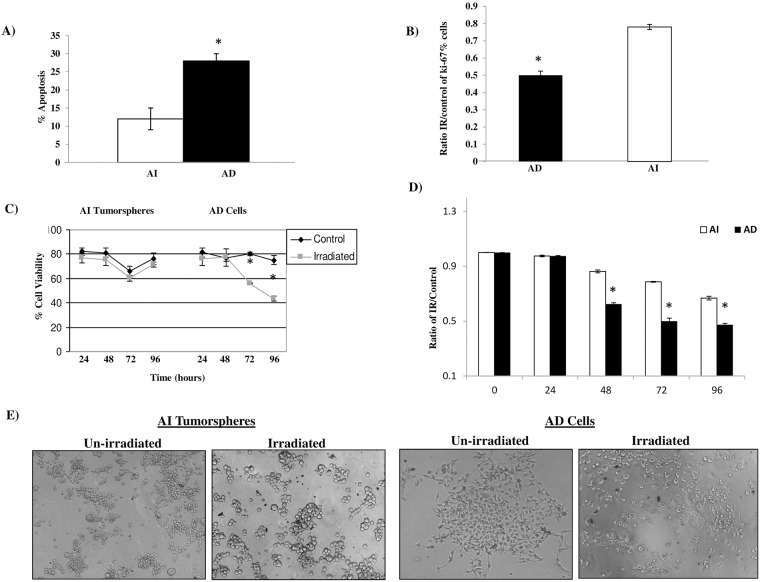
AI tumorspheres exhibit resistance to radio-therapy compared to AD cancer cells.(A) AD cells (black bars) had a significantly (*P < 0.05) higher rate of apoptosis 2 days after a single dose (2.5 Gy) of radiation compared to AI tumorspheres (white bars) as assessed using 7AAD/Annexin V staining. (B) AD cells had a more potent reduction (81% to 38%) in the proliferation marker Ki-67 expression than AI tumorspheres (72% to 52%) at 72 h post radiation compared to control cells. The average ratio of Ki-67% irradiated/control cells in the AI tumorspheres was 0.75 whereas that of the AD cells was 0.45, as derived from the mean of 4 independent experiments run in triplicates and presented ±SEM of multiple experiments. (C) AI tumorspheres (left side) exhibited a higher number of viable cells over 96 h post radiation compared to AD cells (right side) as determined by counting viable (non-trypan blue stained) and non-viable (trypan blue stained) cells, used in support of the XTT cell proliferation assay. (D) The average ratio of irradiated/control neuroblastoma AD cells (black bars) and that of AI tumorspheres (white bars) was derived from the absorbance of 4 independent experiments run in triplicates and graphed. The ratio was significantly different (*P < 0.05) between the AD cells and AI tumorspheres at 48, 72 and 96 h post radio-therapy(2.5 Gy) indicating the radio-resistant nature of the AI tumorspheres compared to the AD cells. (E) AD cells exhibit increased cell death after radio-therapy compared to AI tumorspheres as shown in the photographic representation of the AI tumorspheres and AD Cells 72 h post radio-therapy revealing more dead cells and cellular debris in the AD cells compared to the AI tumorspheres. * indicates a P value < 0.05. Results represent the mean ± SEM of multiple experiments.